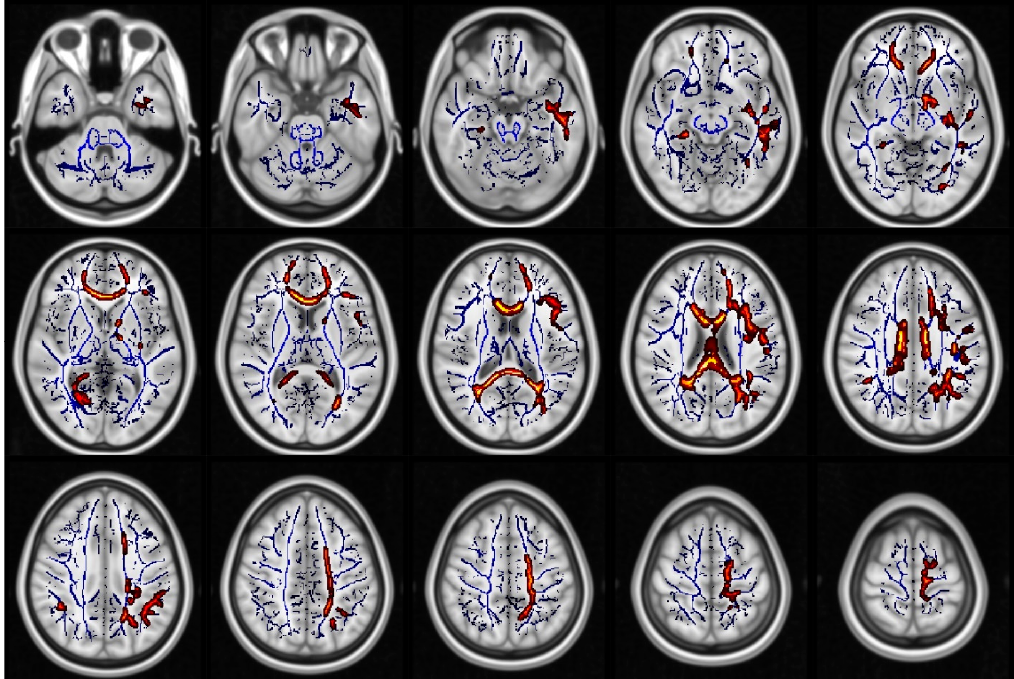
Figure 2. Regions which displayed significant differences in kurtosis anisotropy (KA) (displayed as red and yellow) (CTRL) > glaucoma group (GLA)). The white matter skeleton is shown in blue.